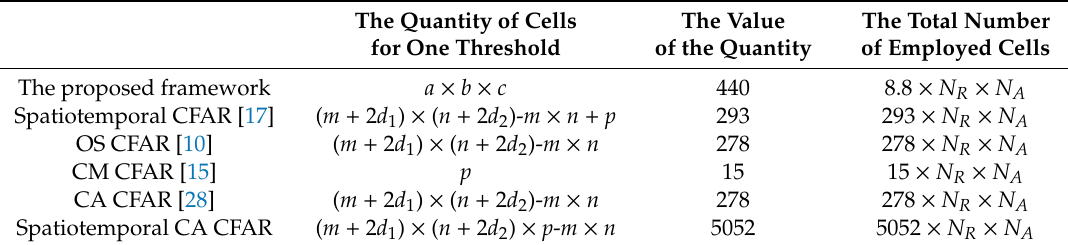
Table 2. The quantity of employed cells for thresholds.